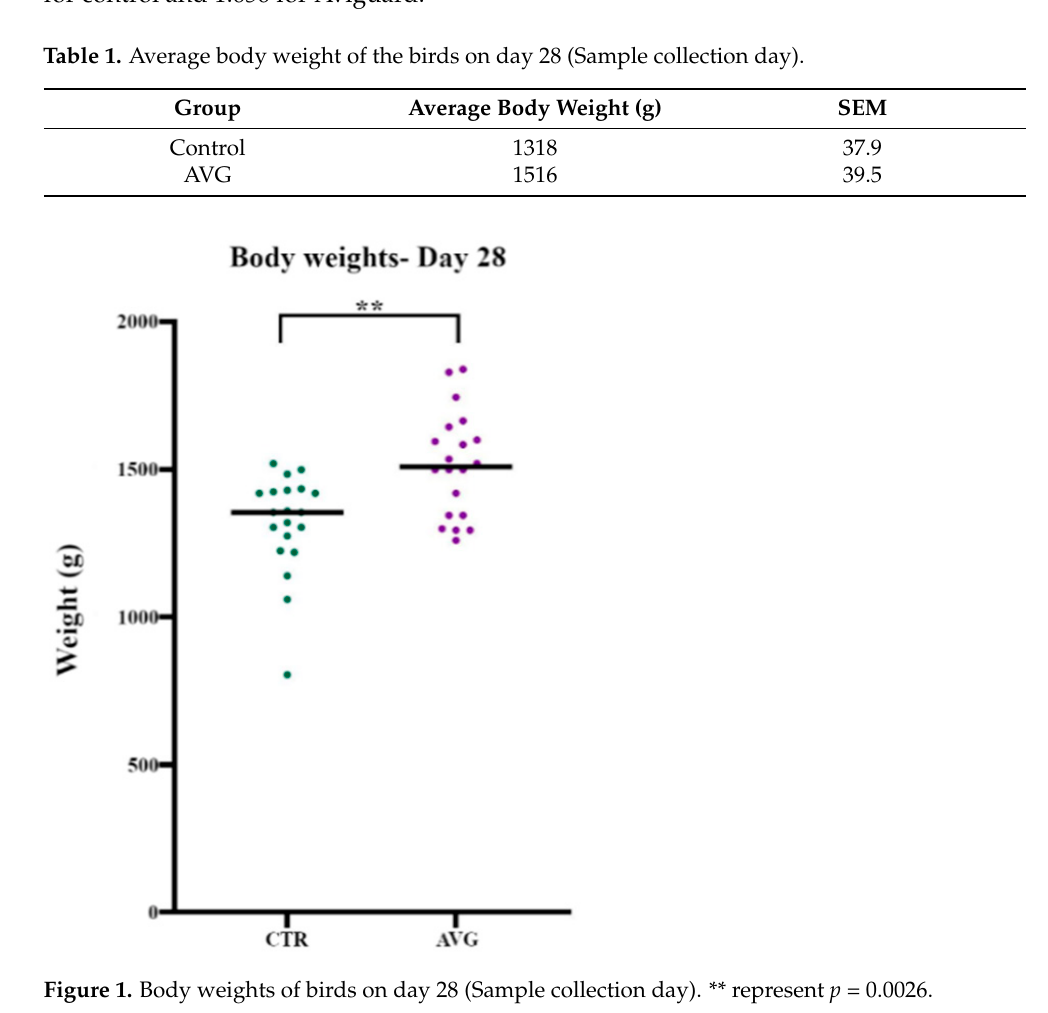
Table 1. Average body weight of the birds on day 28 (Sample collection day).